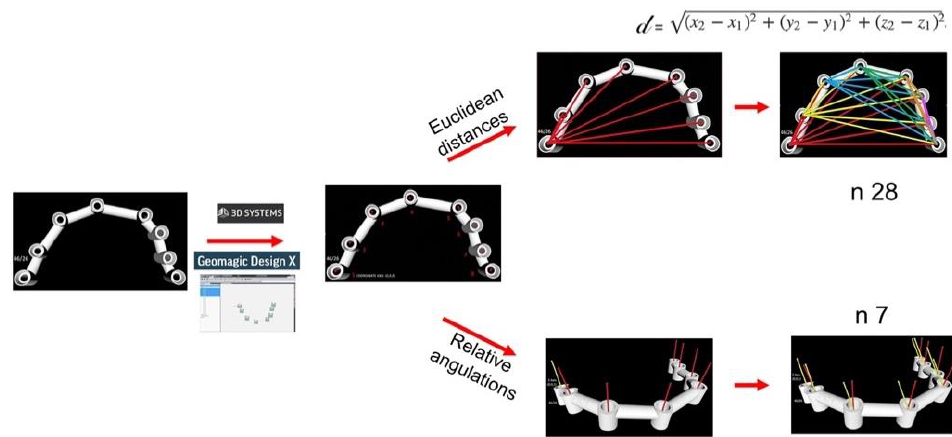
Figure 2. With reverse engineering software, center points and rotational axis of abutments are calculated for 30 designed suprastructures. From each suprastructure 28 Euclidean distances and 7 relative angulations were analyzed.